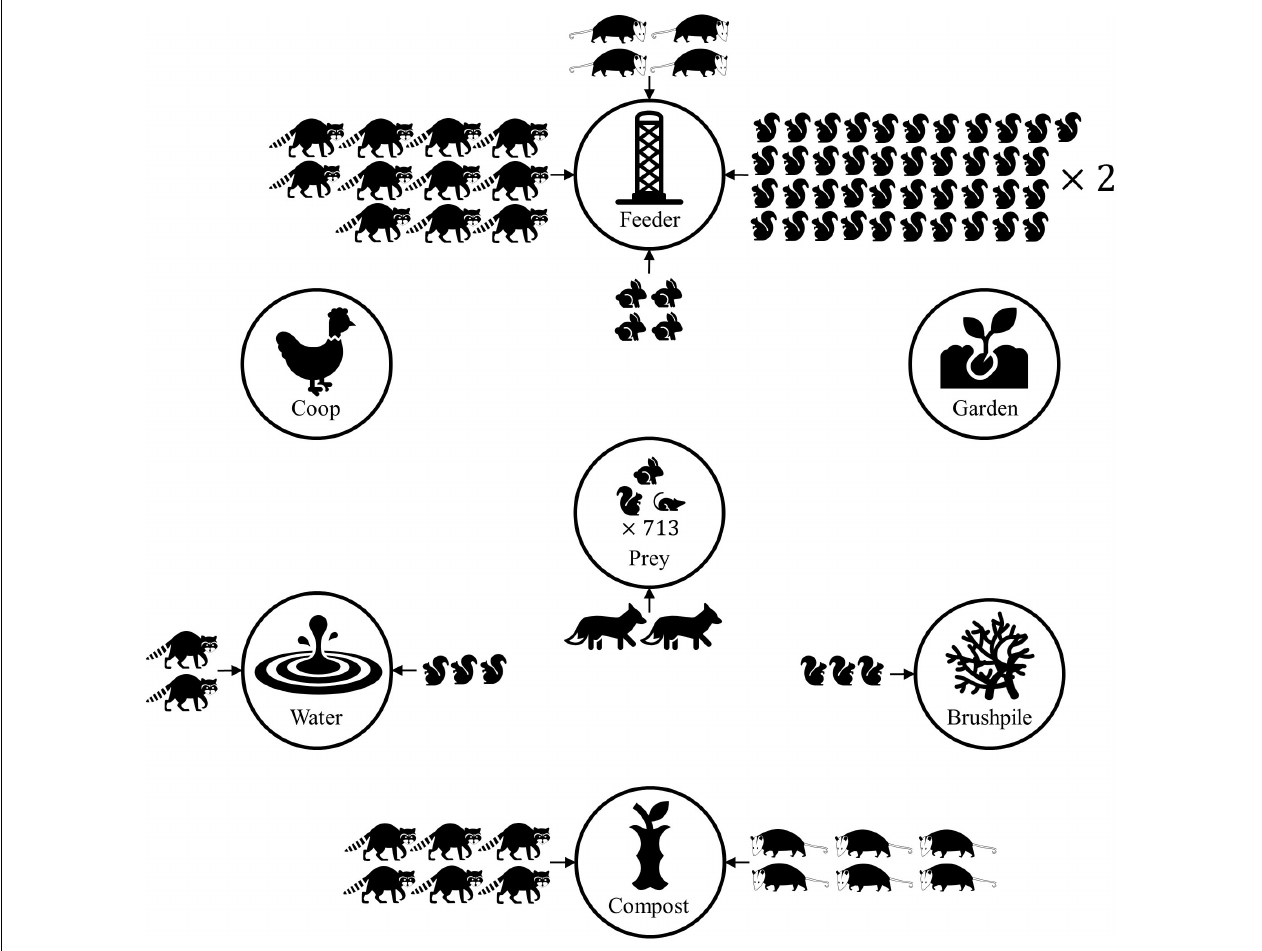
FIGURE 5 | Conceptual diagram demonstrating predicted mammal count at yard features, based on Poisson regression models of mammal count data from residential yards in Raleigh, North Carolina in 2016. Only strong associations between features and mammal count are shown. Eastern gray squirrels, eastern cottontails, northern raccoons, and Virginia opossums had higher relative abundance at some yard features, compared to control sites within a yard. Yards with higher prey (rodents and lagomorphs) relative abundance were more likely to have higher predator (wild canid) relative abundance. The number of mammal icons represents the relative risk ratio, compared to a control site in the yard. Thus, a yard feature with two raccoons suggests there are predicted to be twice as many raccoons at the feature, relative to the control site. The predicted number of predator detections doubled when prey detections increased by